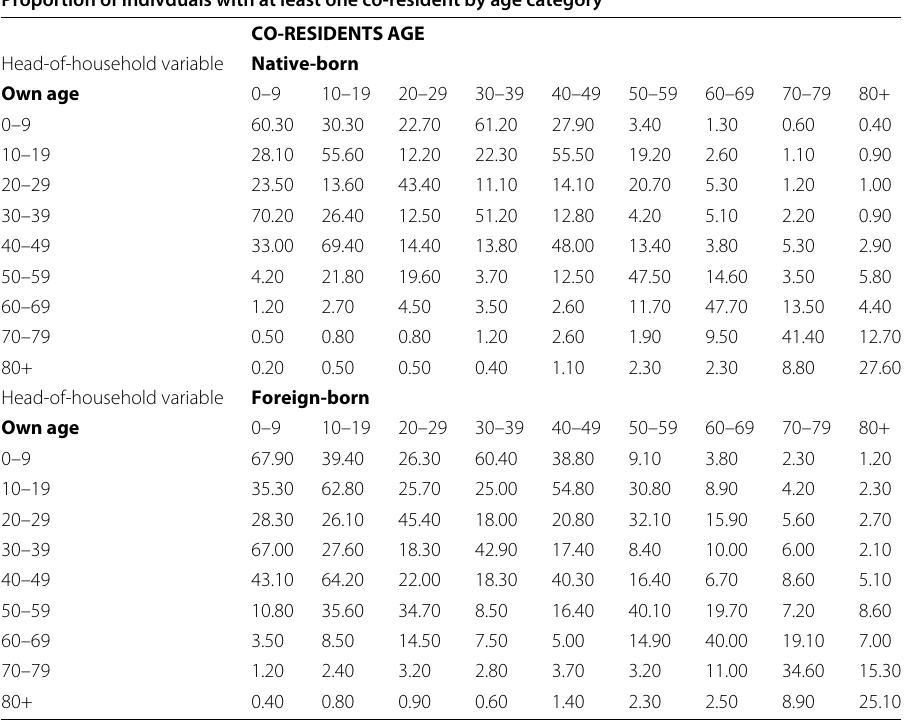
Table 12 Proportion of individuals with at least one co-resident by age and head-of-household nativity status Proportion of indivduals with at least one co-resident by age